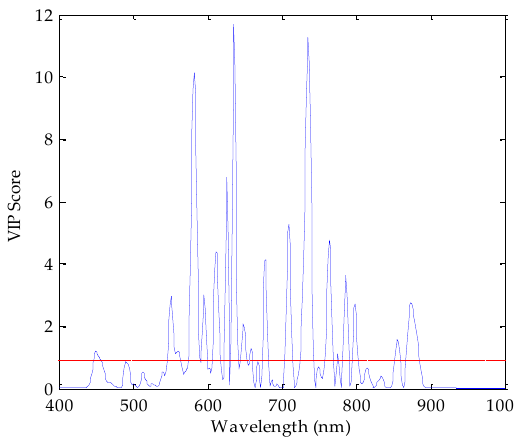
Figure 4. VIP score values calculated from partial least square regression (PLSR) model based on 2D. The solid horizontal line was set by the threshold value 1. VIP: Variable importance projection.